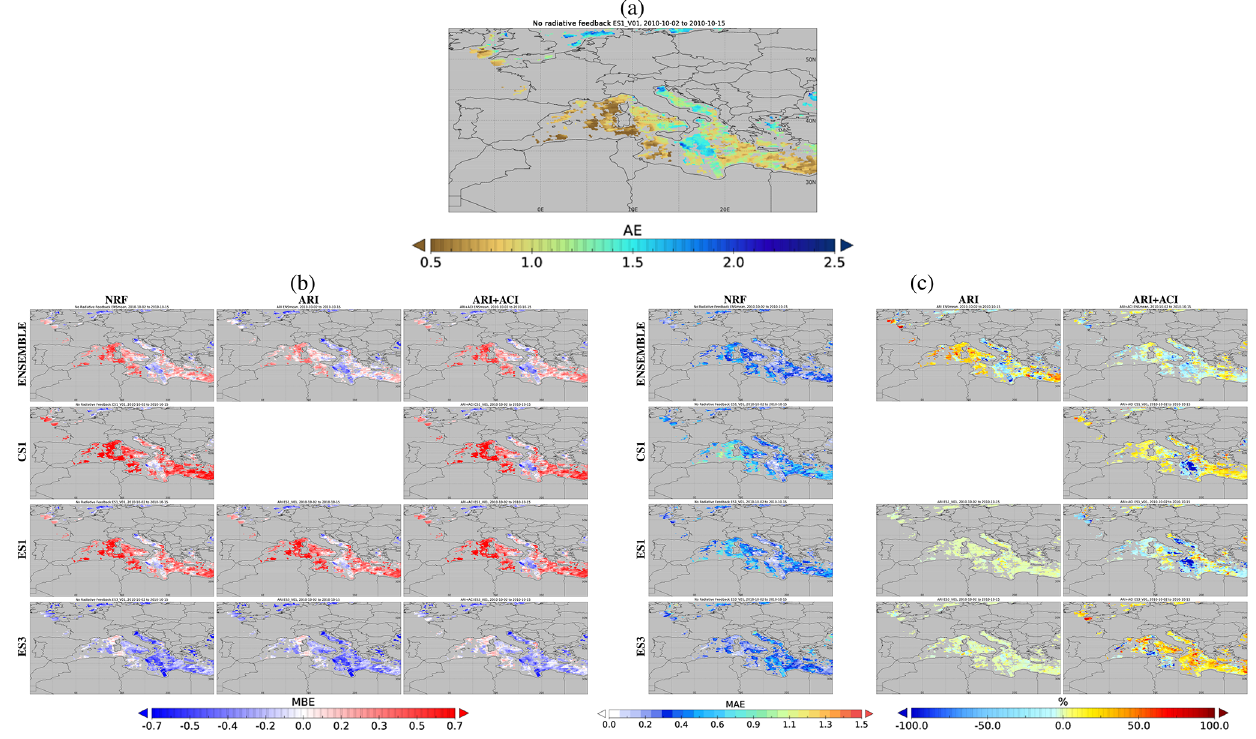
Figure 8. Model-MODIS comparison of AE between 550 and 860nm for the Saharan desert dust outbreak case: (a) satellite values; (b) MBE for NRF (first column), ARI (second) and ARI + ACI (third); and (c) MAE for the NRF simulations (first column) and their improvements due to ARI (second) and ARI + ACI